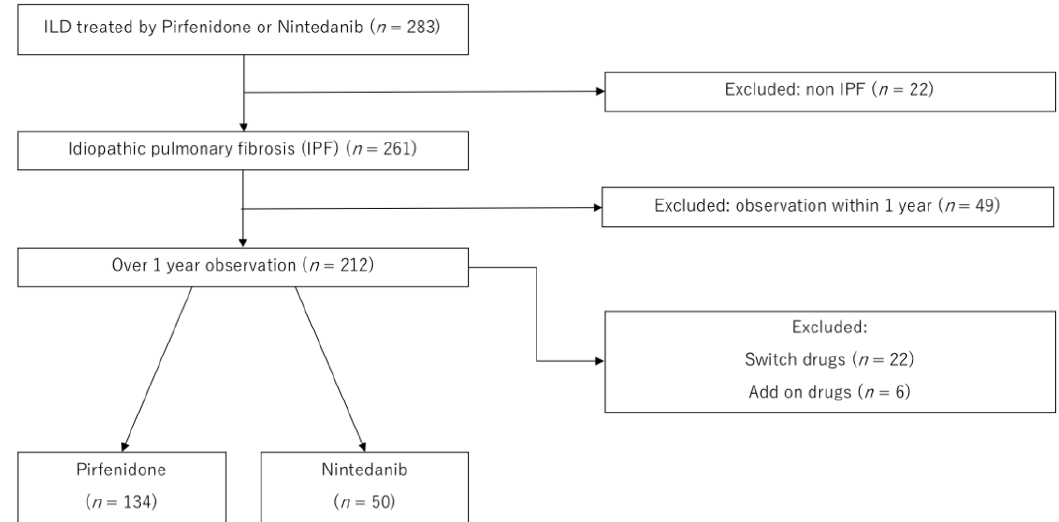
Figure 1. Study population.